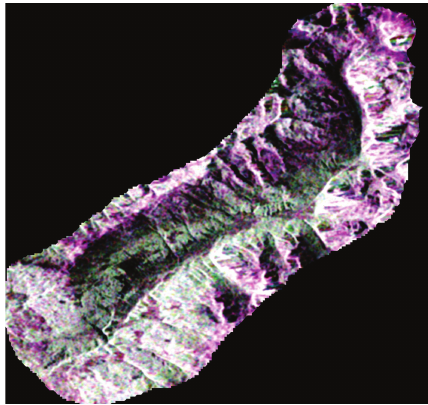
Figure 2: RADARSAT2 image acquired on July 21st, false colorRGB composition (R = HH, G = HV, B = VV).